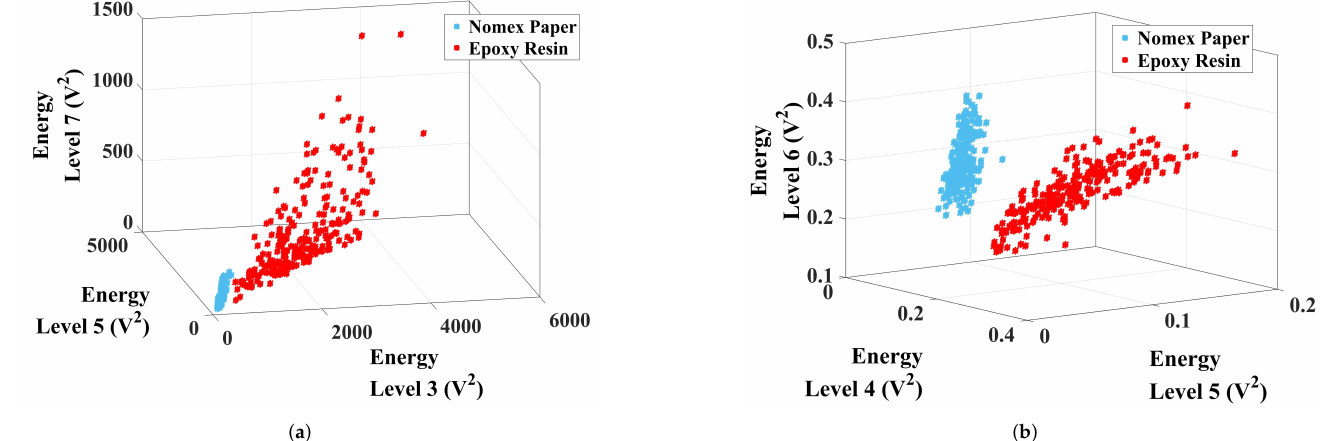
Figure 8. Clusters formed by the best combinations of ( a ) approximation and ( b ) detail coefficients.